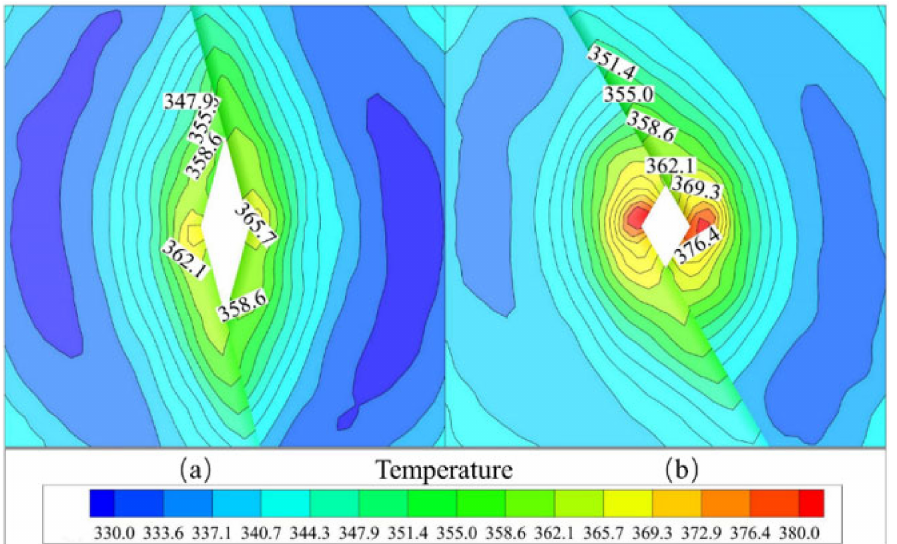
Figure 11. Temperature distribution of 15 ◦ cross angle susceptor with two different geometric structures: ( a ) outer angle 105 ◦ and ( b ) outer angle 120 ◦